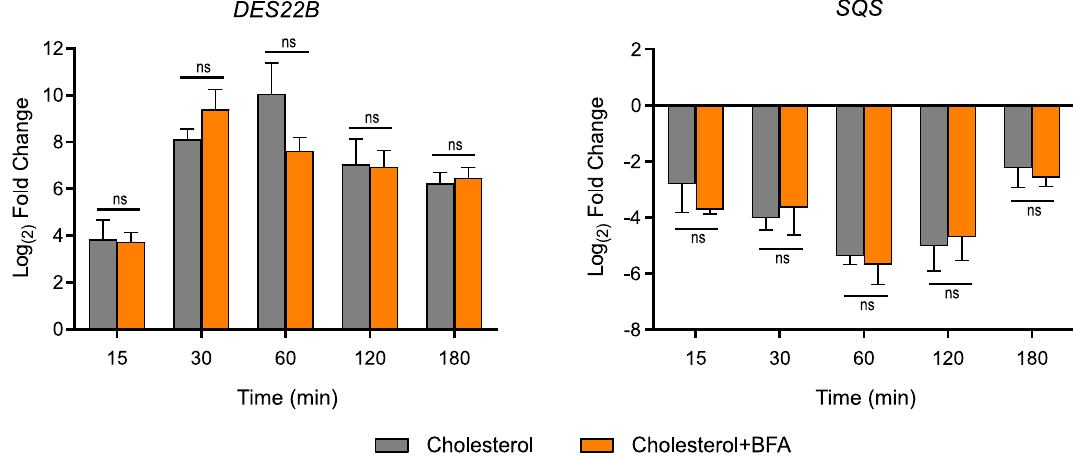
Figure 8. Effect of Brefeldin A on the expression of cholesterol-regulated genes. Time course of the expression of DES22B and SQS in wild - type cells. Cultures at exponential growth phase were incubated with 36 μM Brefeldin A (BFA) or vehicle for 2 h prior to the addition of 26 μM cholesterol. Total RNA was extracted at different times after treatment with cholesterol and gene expression was analyzed by RT-qPCR. Data are expressed as mean ± SD (n = 3) log 2 fold change relative to cells before the addition of cholesterol. Statistical analysis was performed by repeated measures two-way ANOVA with Bonferroni post hoc test to compare treatments at each time; ns, not significant